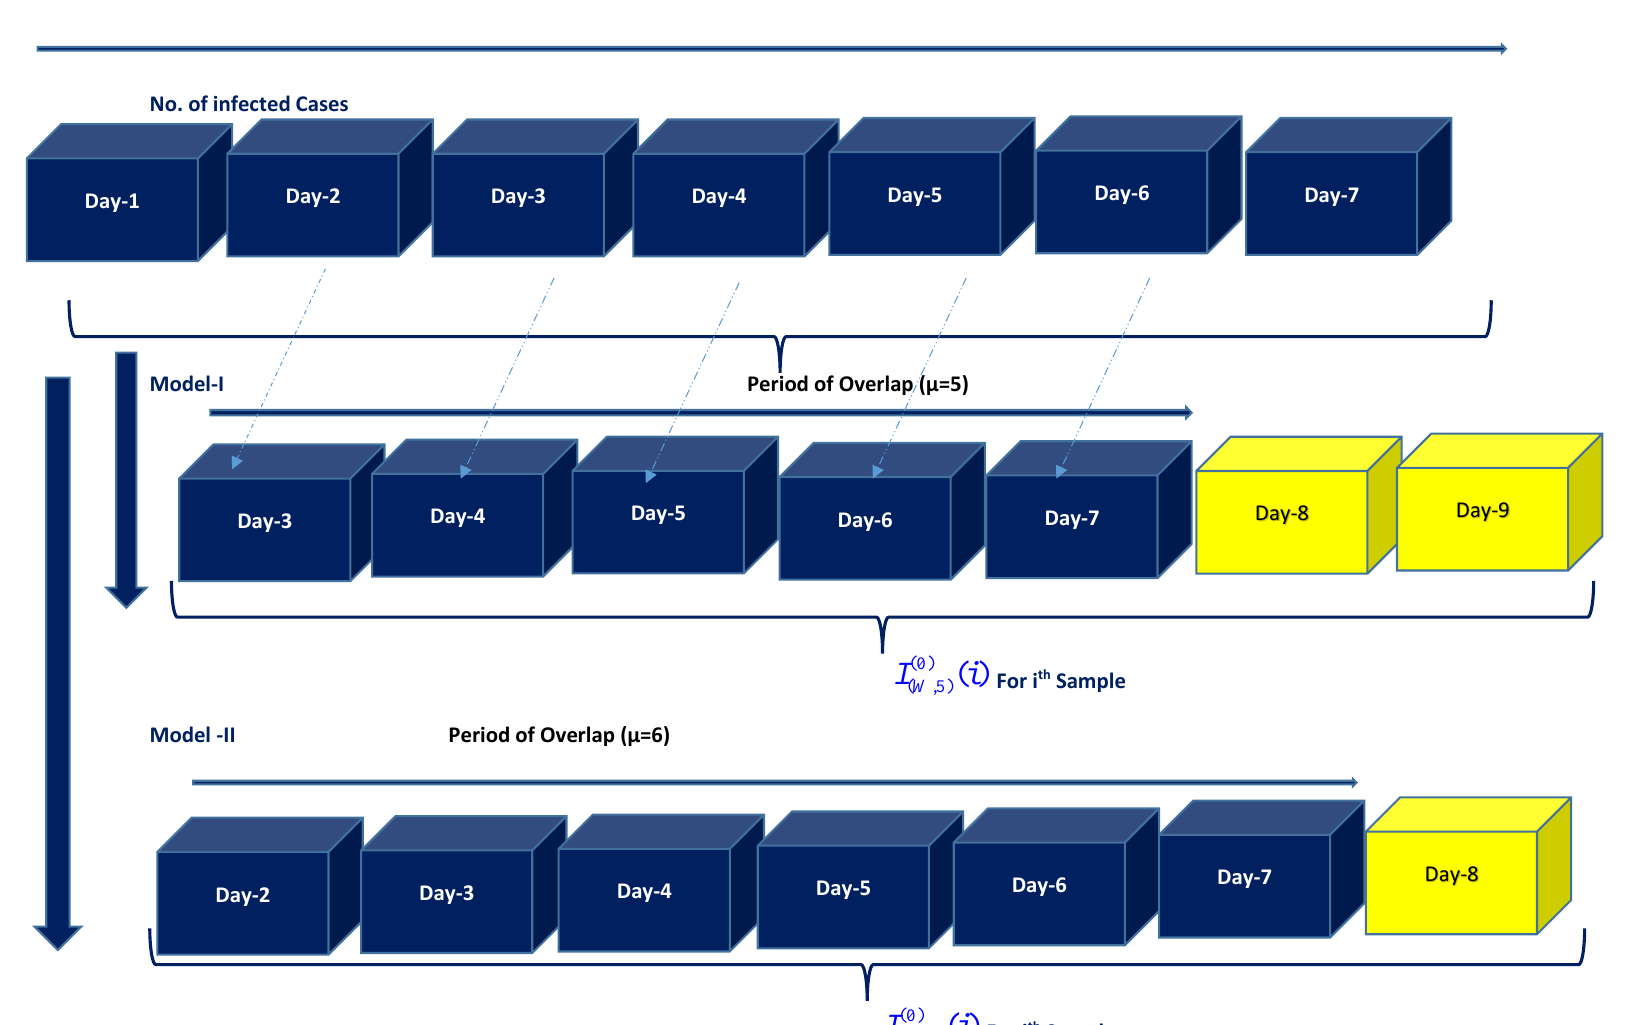
Figure 2. Proposed Rolling horizon based Grey Forecasting